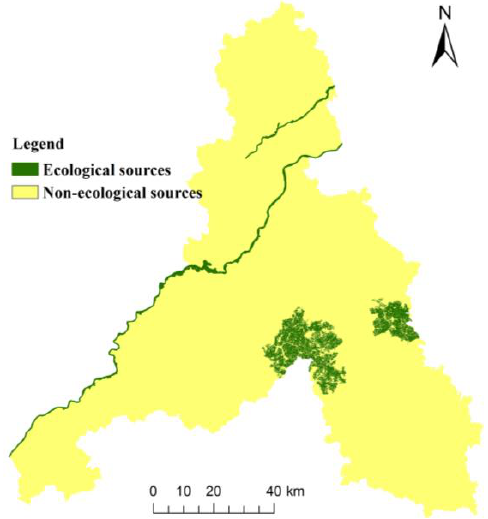
Figure 5. Ecological sources based on the value of ecosystem services.